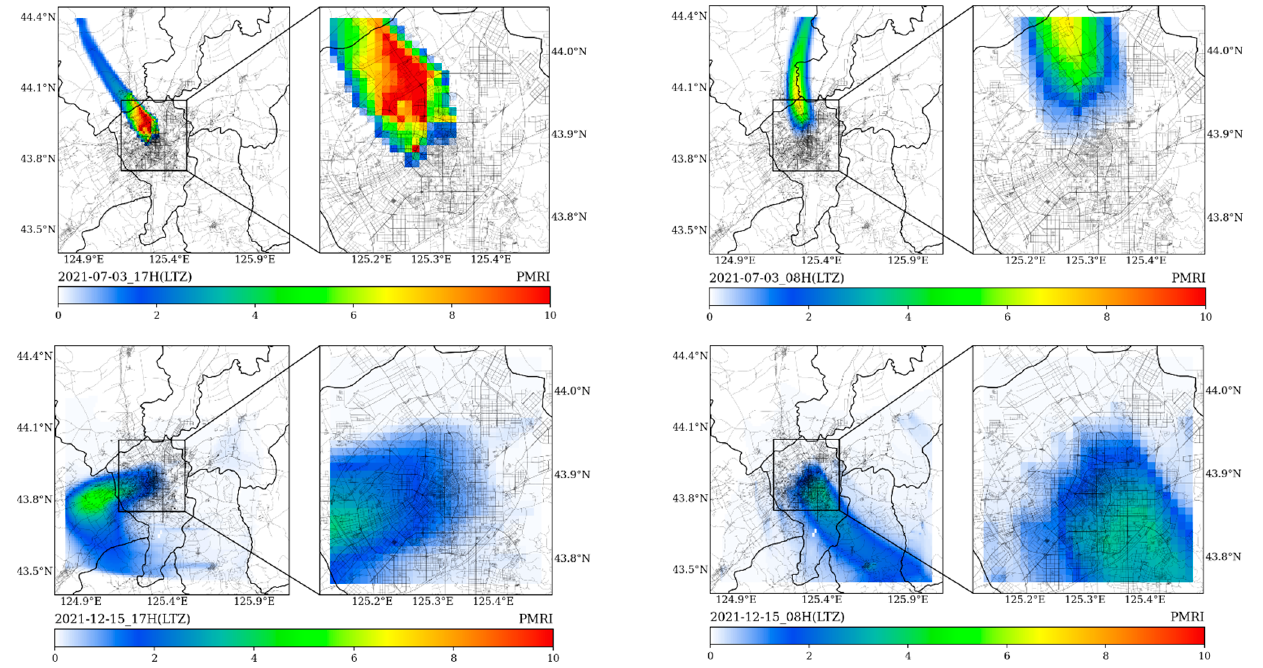
Figure 6. The spatial distributions of forecasted hourly PMRIs during typical hours (08H and 17H, LTZ) of traffic jams on 3 July and 15 December.